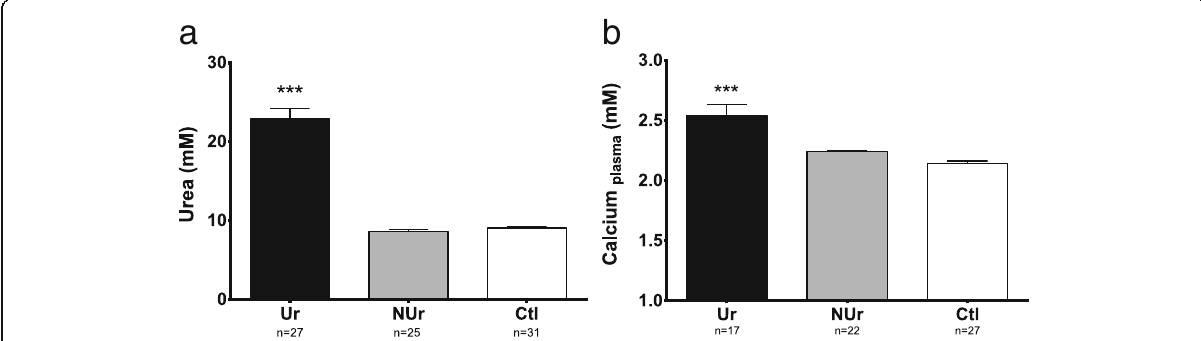
Fig. 2 Urea ( a ) and calcium ( b ) plasma level. a Urea plasma level (mM) in uremic ApoE − / − mice (Ur, n = 27), non-uremic ApoE − / − mice (NUr, n = 25), and control Bl6 mice (Ctl, n = 31). b Calcium plasma level (mM) in uremic ApoE − / − mice (Ur, n = 17), non-uremic ApoE − / − mice (NUr, n = 22), and control mice ( n = 27). Data are expressed as mean ± SEM. *** p < 0.0001